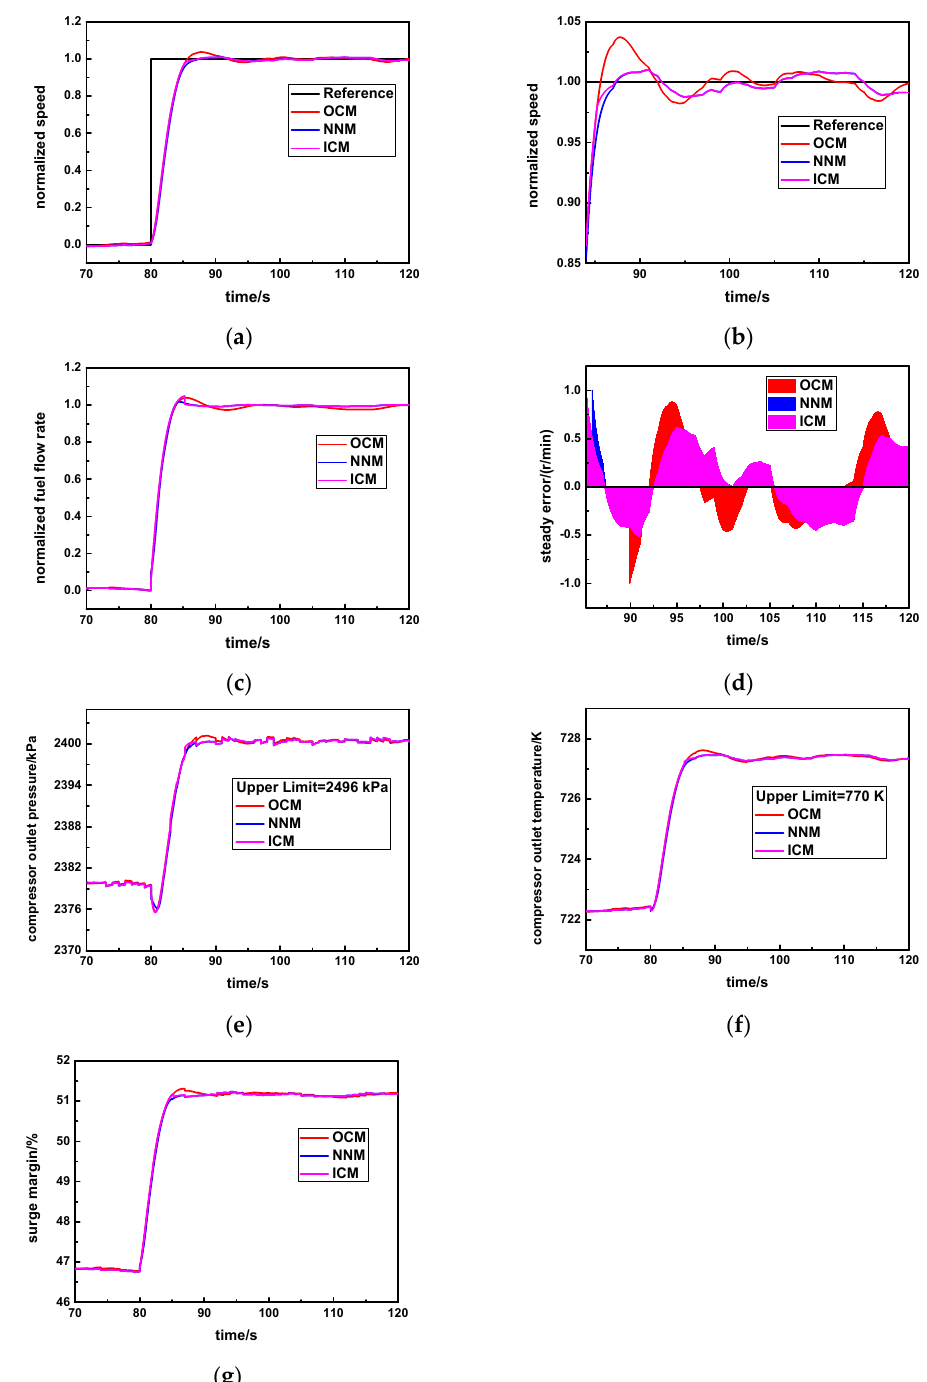
Figure 9. Related parameters distribution of first step test. ( a ) Speed response curve, ( b ) Locally enlarged speed curve, ( c ) Fuel flow rate, ( d ) Steady error, ( e ) Compressor outlet pressure, ( f ) Compressor outlet temperature, ( g ) Surge margin of compressor. Table 2. Tracking performance indexes of three control methods.